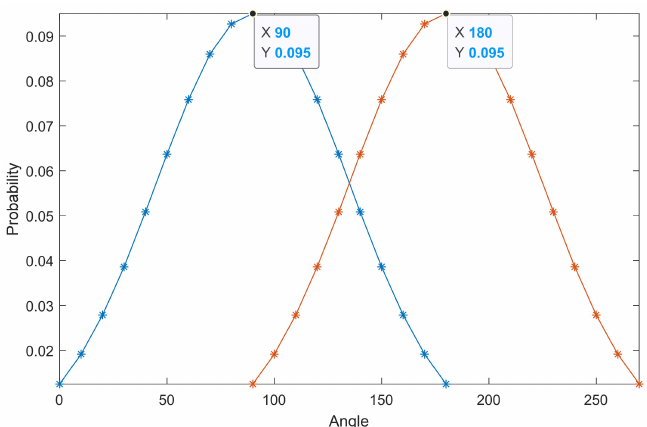
Figure 7. Comparison of orientation distribution of different OMDV. The blue curve represents an orientation distribution of OMDV at 90 ◦ and the red curve represents an orientation distribution of OMDV at 180 ◦